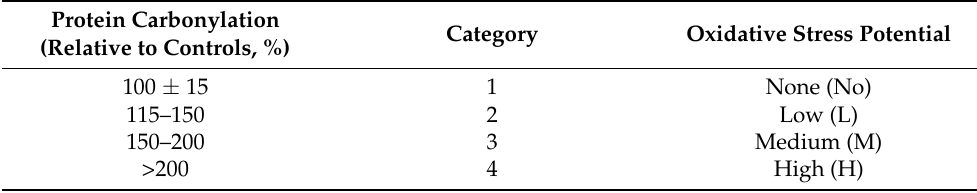
Table 2. Oxidative stress potential scoring based on protein carbonylation.